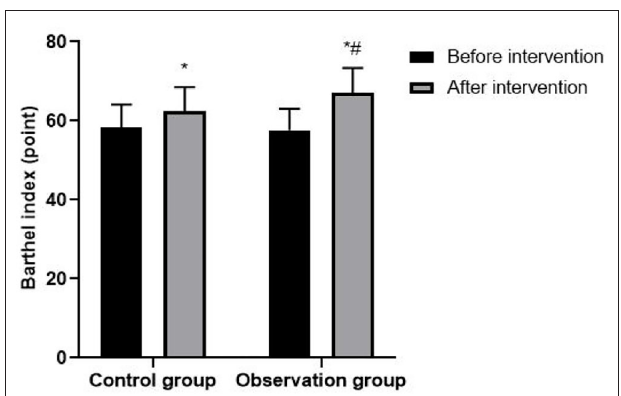
FIGURE 3 | Ability of daily living of patients. Compared with before intervention, * P < 0.05; compared with control group, # P <